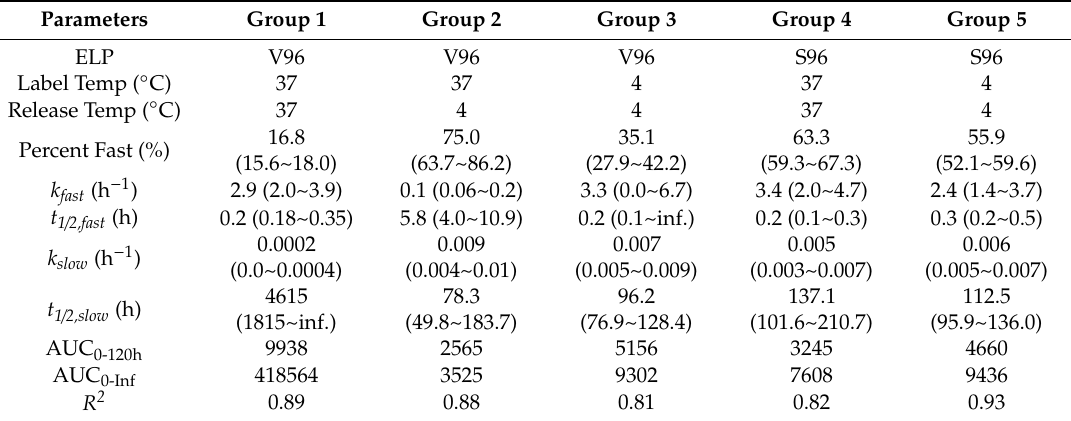
Table 3. Release kinetics of ELPs from Proclear Compatibles TM contact